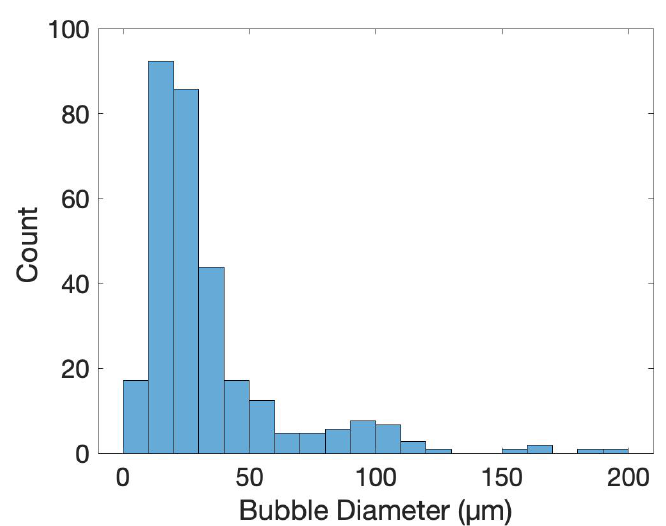
Figure 6. A histogram of bubble size collected in four separate locations on a microstructured polypyrrole film, totalling 1 mm 2 . The creation methodology of bubble entrapment lead to a large amount of bubbles with diameters between 10 to 30 mm, seen in Figures 4 and